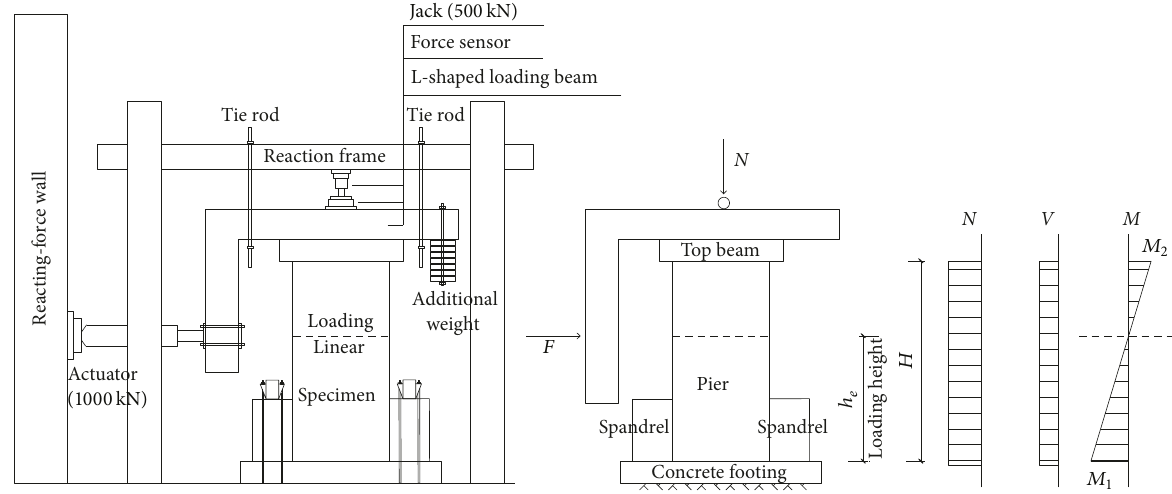
Figure 8: Equipment figure and the internal force diagram of specimens.